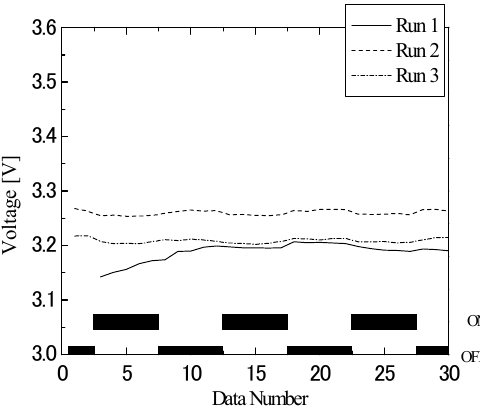
Fig. 6 Output voltage by PSJA on/off x D =75mm